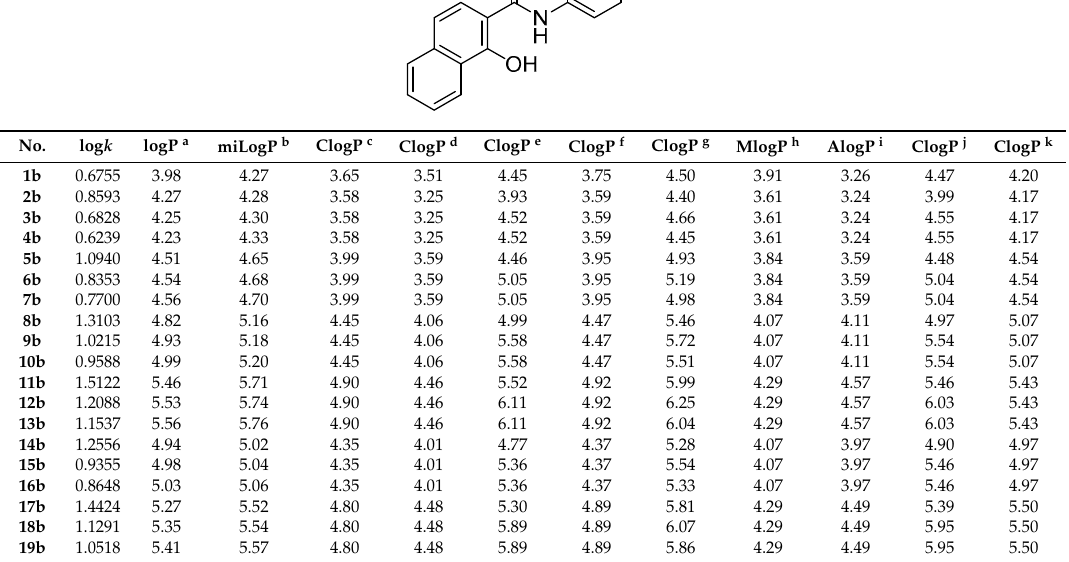
Table 2. N -substituted 1-hydroxynaphthalene-2-carboxanilides 1b – 19b (series B), as well as their determined log k and theoretical partition coefficients calculated by alternative methods.